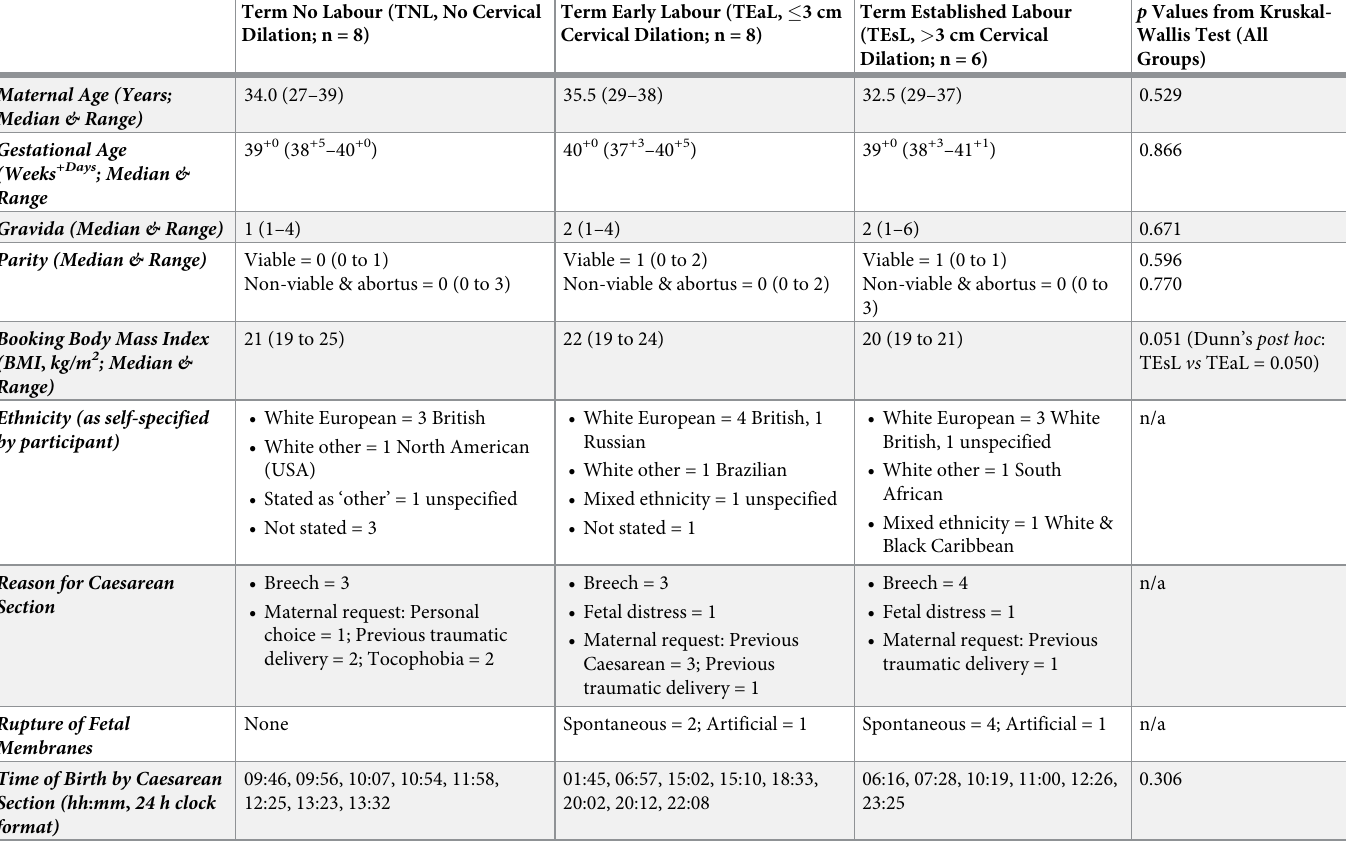
Table 2. Patient demographics for myometrium & placenta biopsies of the RNA-seq cohort—Grouped by phases of labour as determined by cervical dilatation. Term No Labour (TNL, No Cervical Dilation; n = 8)